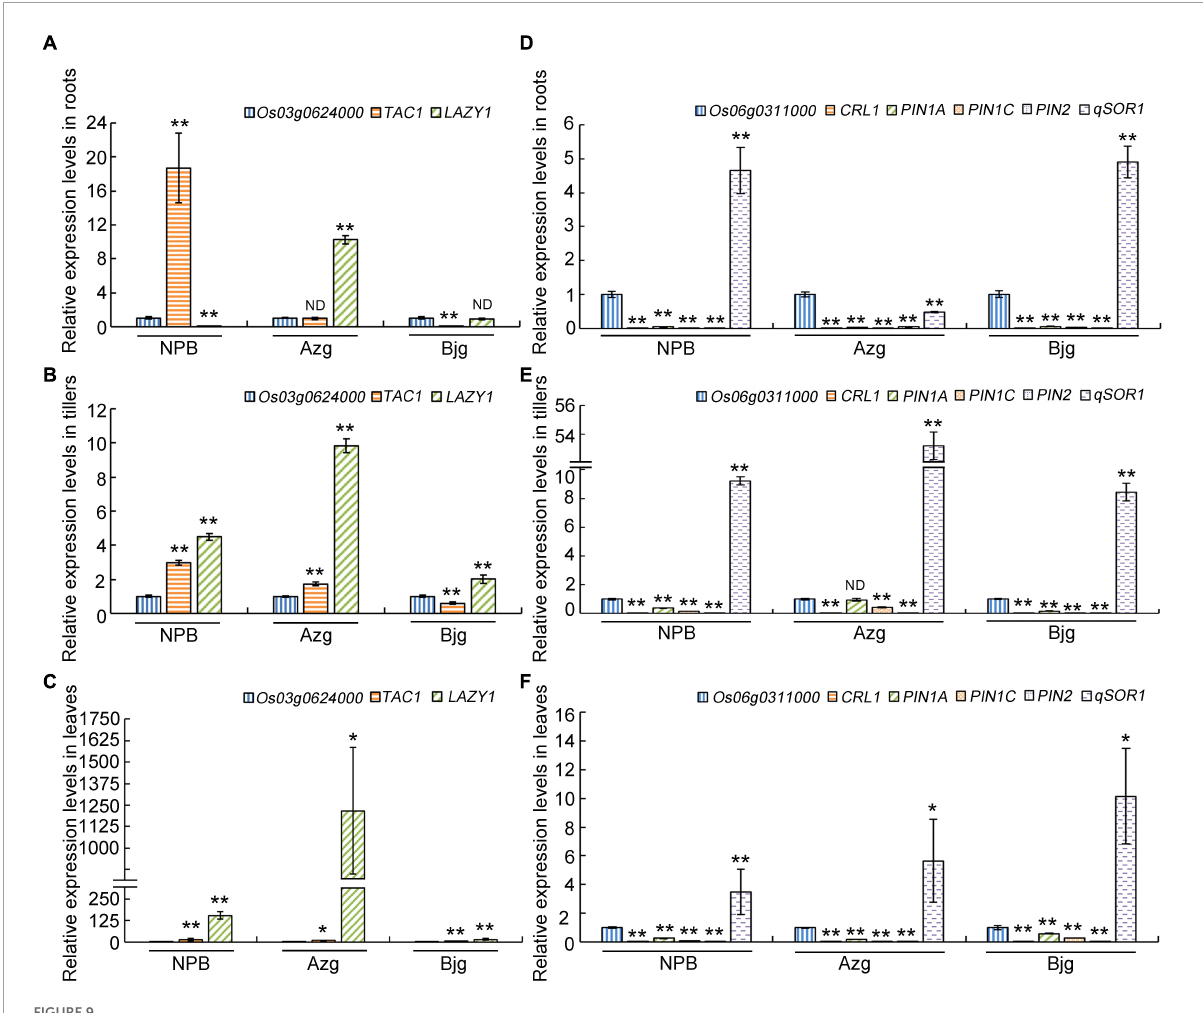
FIGURE9 Gene co-expression detection in different rice varieties. Roots, tillers and leaves of 3-month old rice seedlings grown under drought condition were used to detect gene co-expression levels (A–F) . The levels of Os03g0624000 , LAZY1 , TAC1 (A–C) , Os06g0311000 , CRL1 , PIN1A , PIN1C , PIN2 , and qSOR1 (D–F) in rice roots (A,D) , tillers (B,E) and leaves (C,F) were determined by using real-time PCR. The Actin gene was used as an internal control. The data presented here represent at least three biological replicates. Data are means ± SD. * P < 0.05, ** P < 0.01